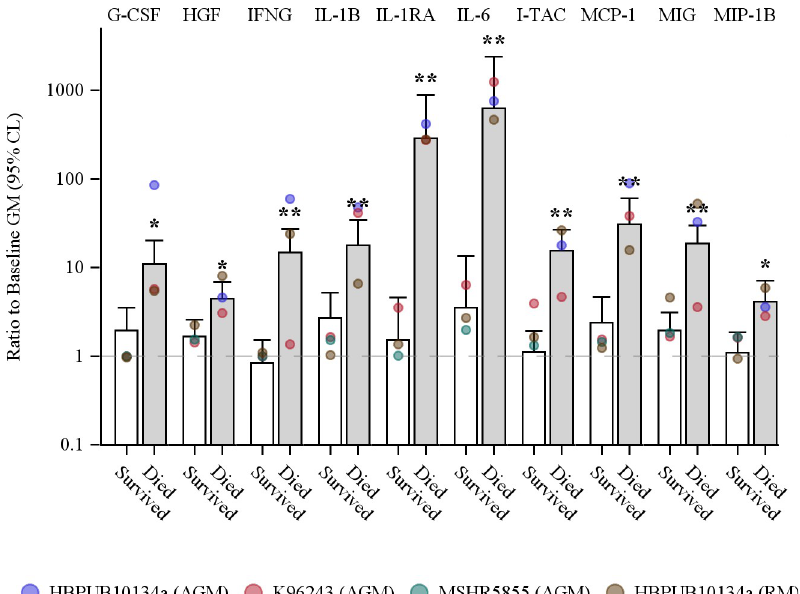
Fig 7. Association of cytokines and chemokines with survival among NHPs aerosolized with B . pseudomallei . Survival was associated with reduced serum levels of some cytokines and chemokines at the terminal bleed. Colored points indicate the group specific geometric means. Bars are estimates of the geometric mean fold increase in concentration and, to adjust for the differing lethality of the strains, reflect the marginal (least square) means of the 2-way ANOVA model (survival x strain/species) without an interaction term. Note that some groups contain only survivors, or only non-survivors. Error bars indicate the extent of the 95% CL. Statistically significant differences between survivors and non-survivors, based on the main effect contrast of the ANOVA model, are indicated by � ( p < 0.05) and �� ( p <